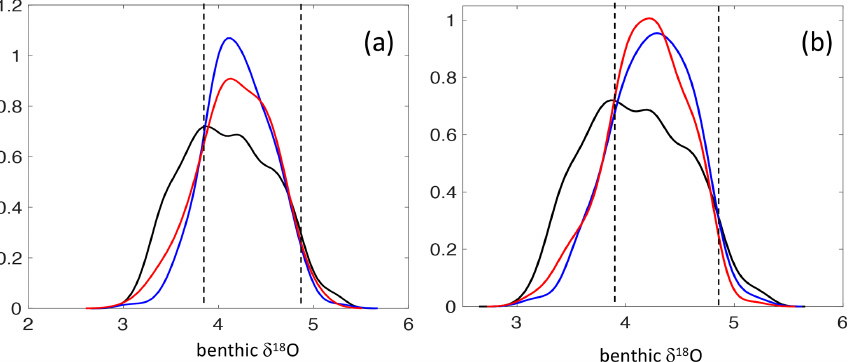
Figure 17. Probability density estimate of benthic δ 18 O for all values (black) and for interstadial (red) and stadial (blue) events for planktic δ 18 O (a) and Zr–Sr (b) . Vertical dashed lines represent benthic δ 18 O threshold values for MCV that define the millennial